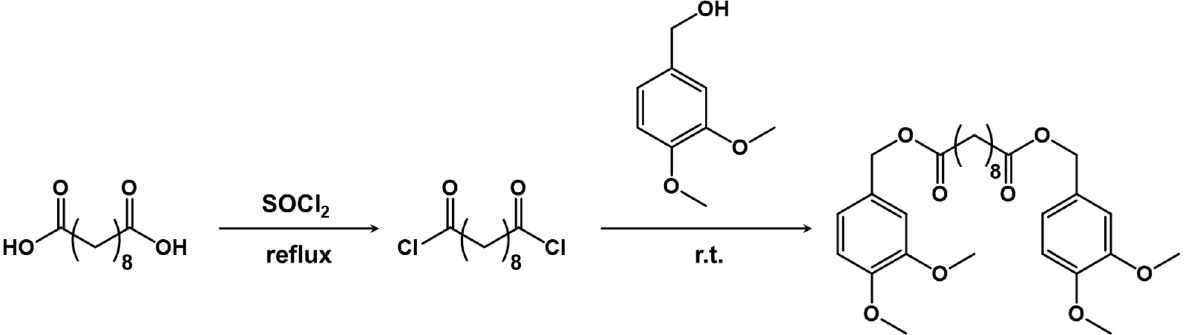
Figure 2. Synthetic path for diveratryl sebacate.